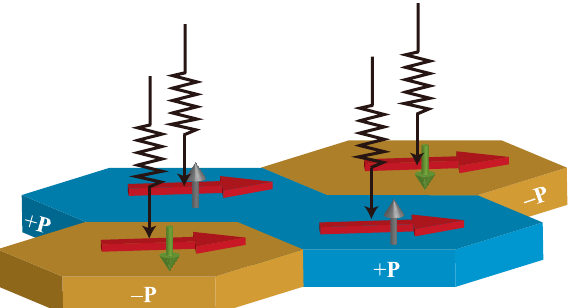
Fig. 4 In-plane and out-of-plane BPVE response with opposite ferroelectric domains for interlayer-sliding ferroelectric materials. The horizontal and vertical arrows denote the in-plane BPVE current and out-of-plane BPVE polarization,